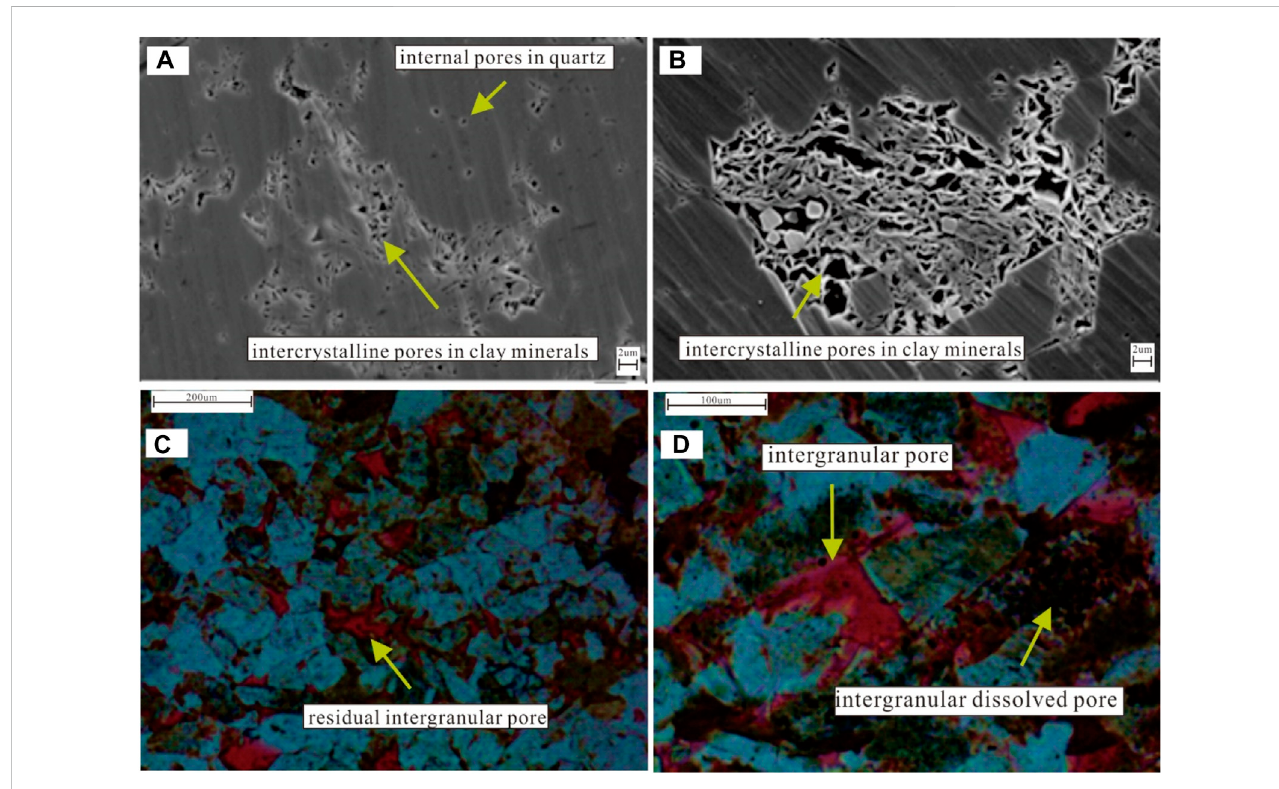
FIGURE 6 PhotomicrographsofthemainporetypesdevelopedintheGaotaizioillayerintheQijiaarea; (A) WellJin341,2076.49m,residualintergranularpores; (B) Well Jin 191, 1863.8m, intergranular and intergranular dissolved pores; (C) Well Qiping 1, 1956.12m, intercrystalline pores and quartz intragranular pores; (D) Well Long 25, 2043.43m, intracrystalline pores.